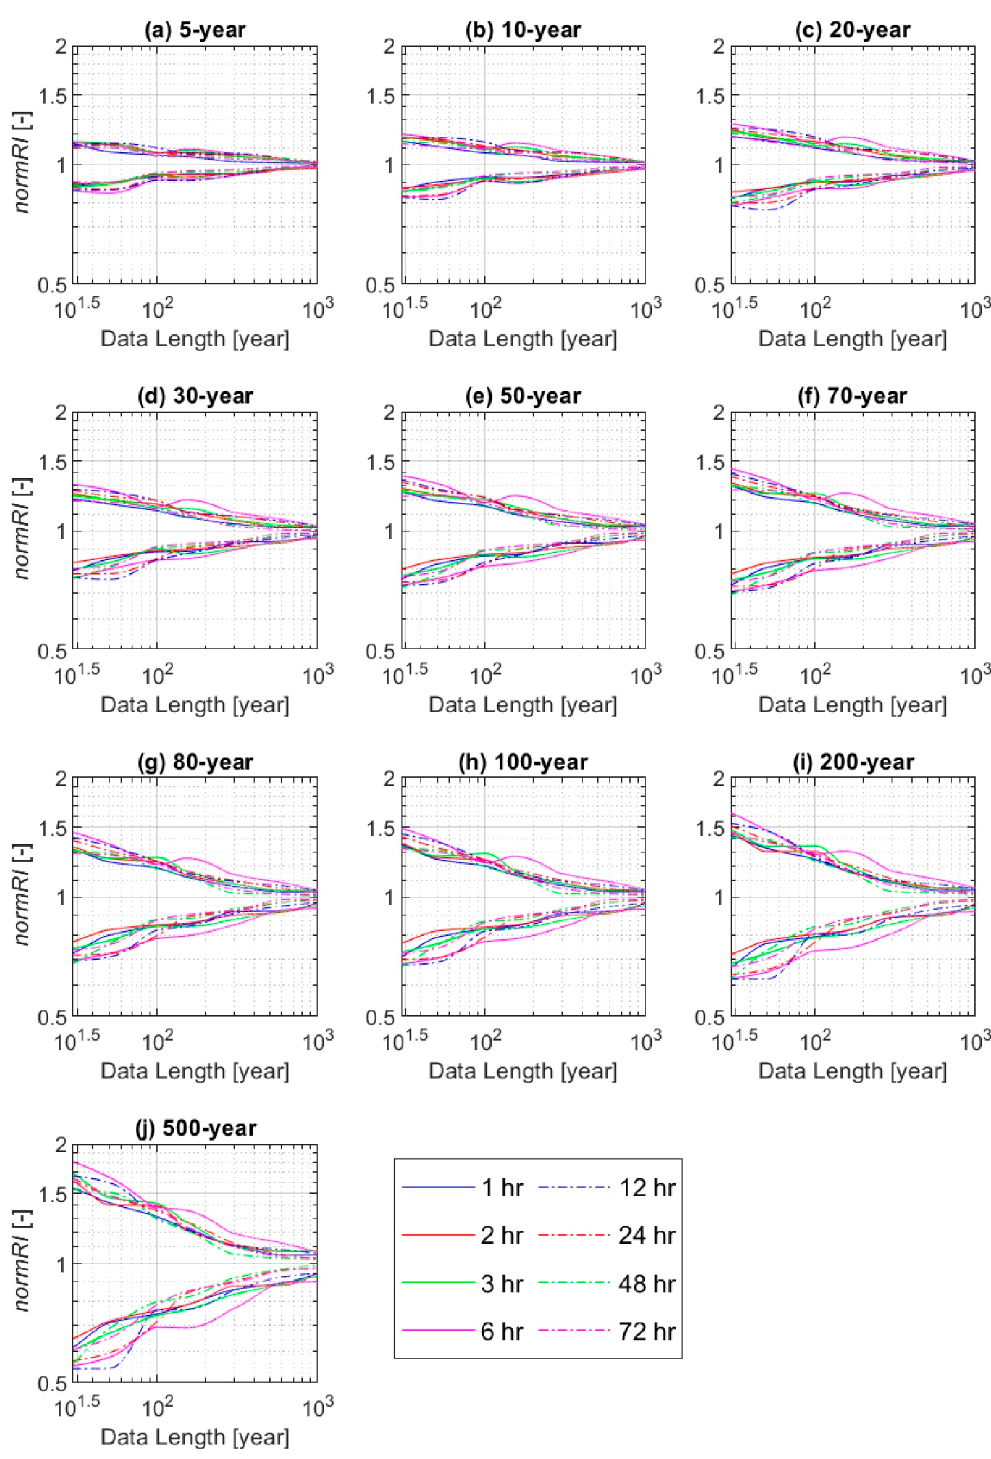
Figure 8. Rainfall frequency estimates normalized by their ensemble mean ( normRI ) for different record lengths of data over 8 durations and 10 return periods in CTL period at the location of Seoul. The below and above lines represent 5th and 95th percentiles of the normRI ensemble, respectively.